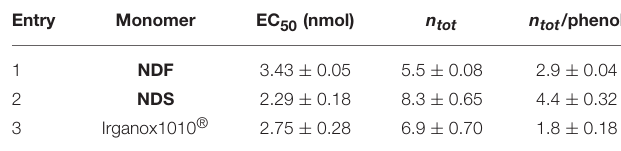
TABLE 1 | Antiradical activity of NDF and NDS .